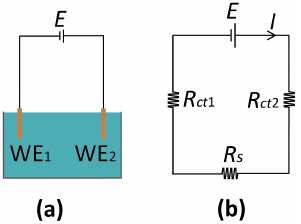
Figure 3. ( a ) Reference-less two-electrode system where E is the applied potential between the